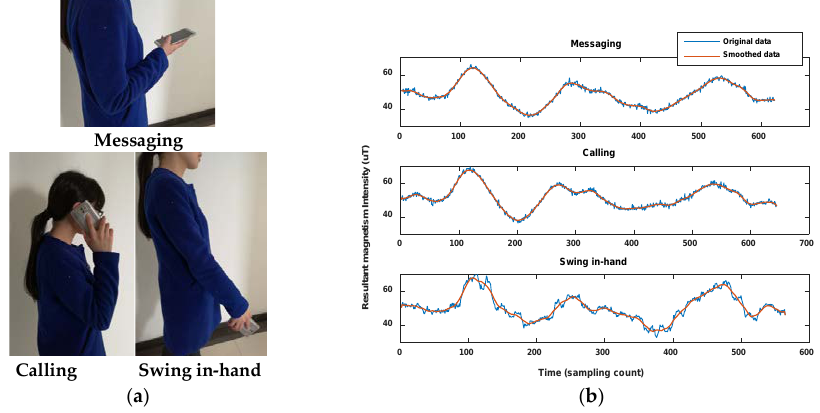
Figure 24. Data comparison for different smartphone attitudes. ( a ) three type of postures when a pedestrian uses smartphone; ( b ) the measured magnetism sequence of them. Table 7. Calculated similarities between three test traces collected using different